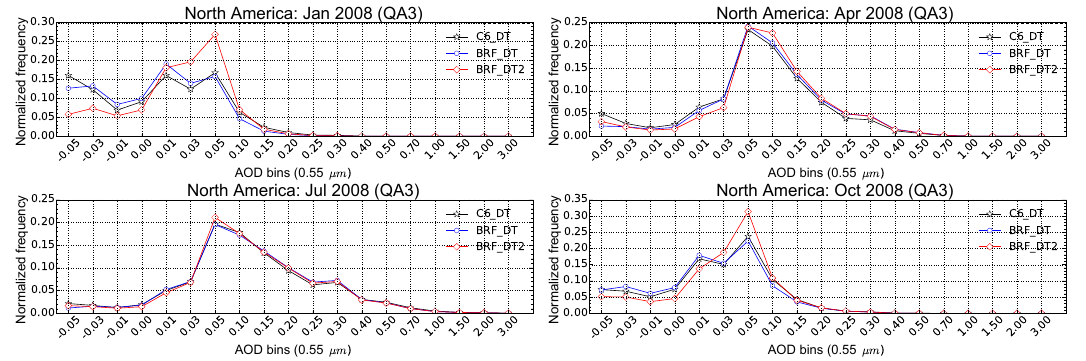
Figure 9. Histograms for North America DT AOD (at 0.55µm) from Aqua for 4 months. Plotted are data from C6_DT, BRF_DT and BRF_DT2 with QA = 3, labeled as QA3. Bin labels represent the lower boundary of the bin. For example, a bin labeled as − 0.05 means the AOD between − 0.05 and −